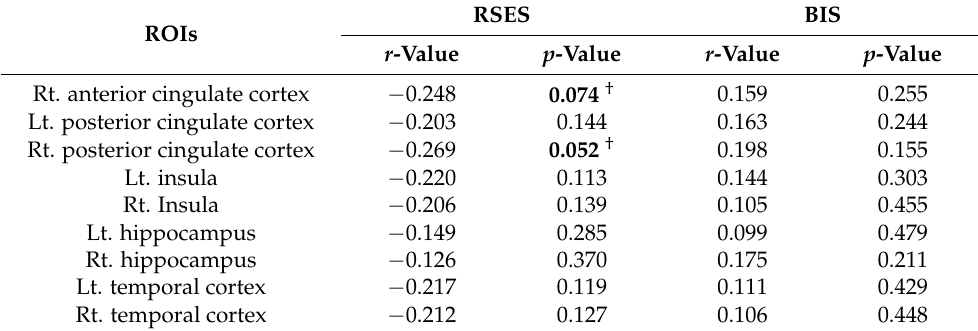
* Asterisk indicates statistical significance at p < 0.05. † Cross marks indicate the tendency at p < 0.1. BP ND , binding potential with respect to non-displaceable compartment; ROI, region of interest; PFC, prefrontal cortex; RSES, Rosenberg Self-Esteem Scale; BIS, Barratt Impulsiveness Scale; Lt, Left; Rt, Right.